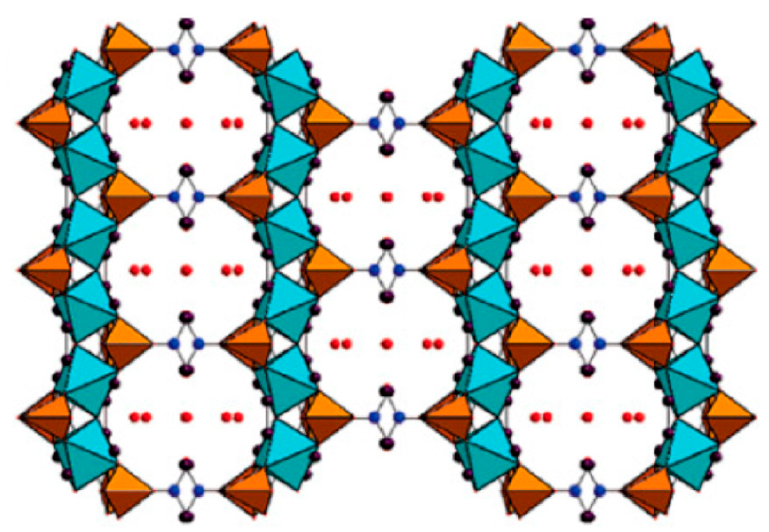
Figure 4. Structure of MIL-91(Ti) viewed along the c axis. Color code: titanium octahedra: cyan, phosphorus tetrahedra: orange, oxygen: red, nitrogen: blue, and carbon atoms: purple. Reprinted with permission from [60]. Copyright (2006), American Chemical Society.